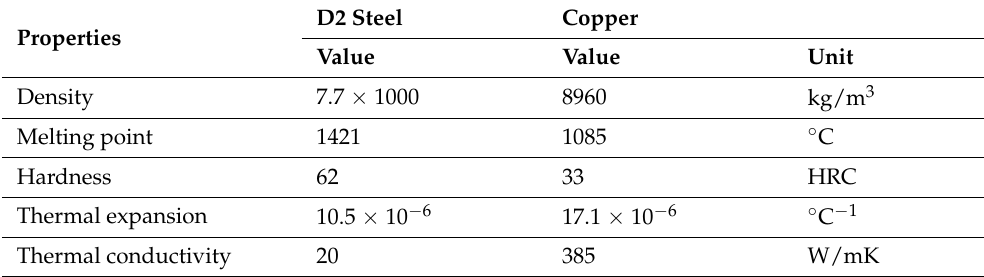
Table 2. Characteristics of copper and D2-grade steel tool